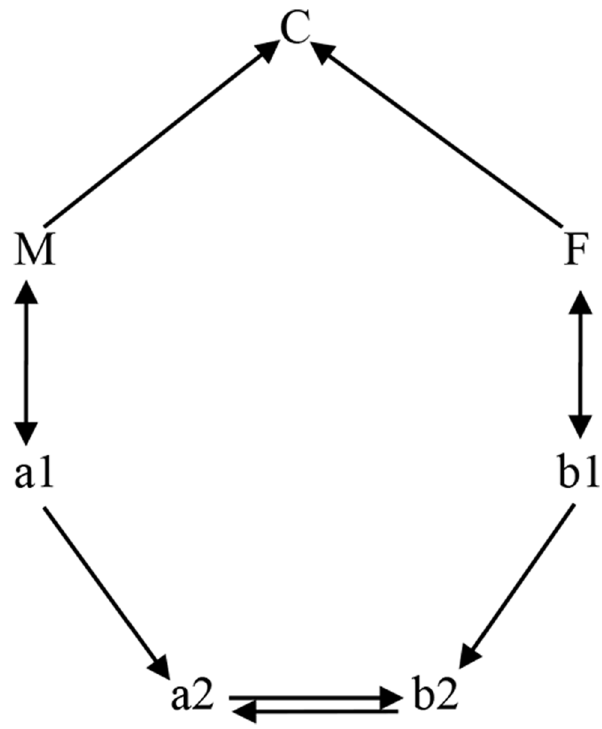
Figure 1. Flow of